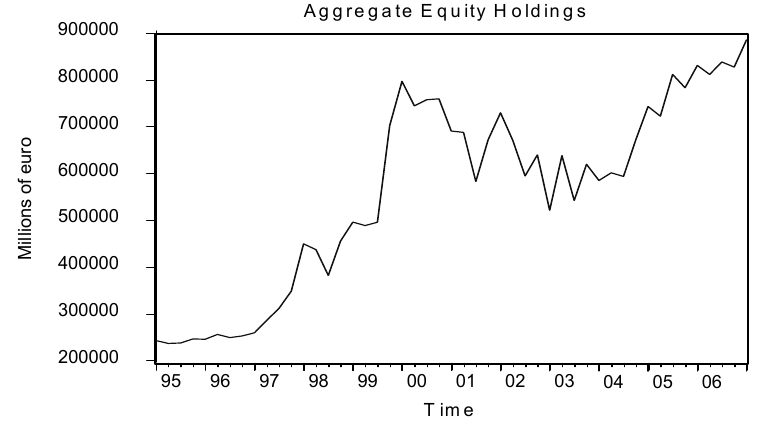
Figure 1 – Aggregate Equity Holdings; our elaboration based on FA